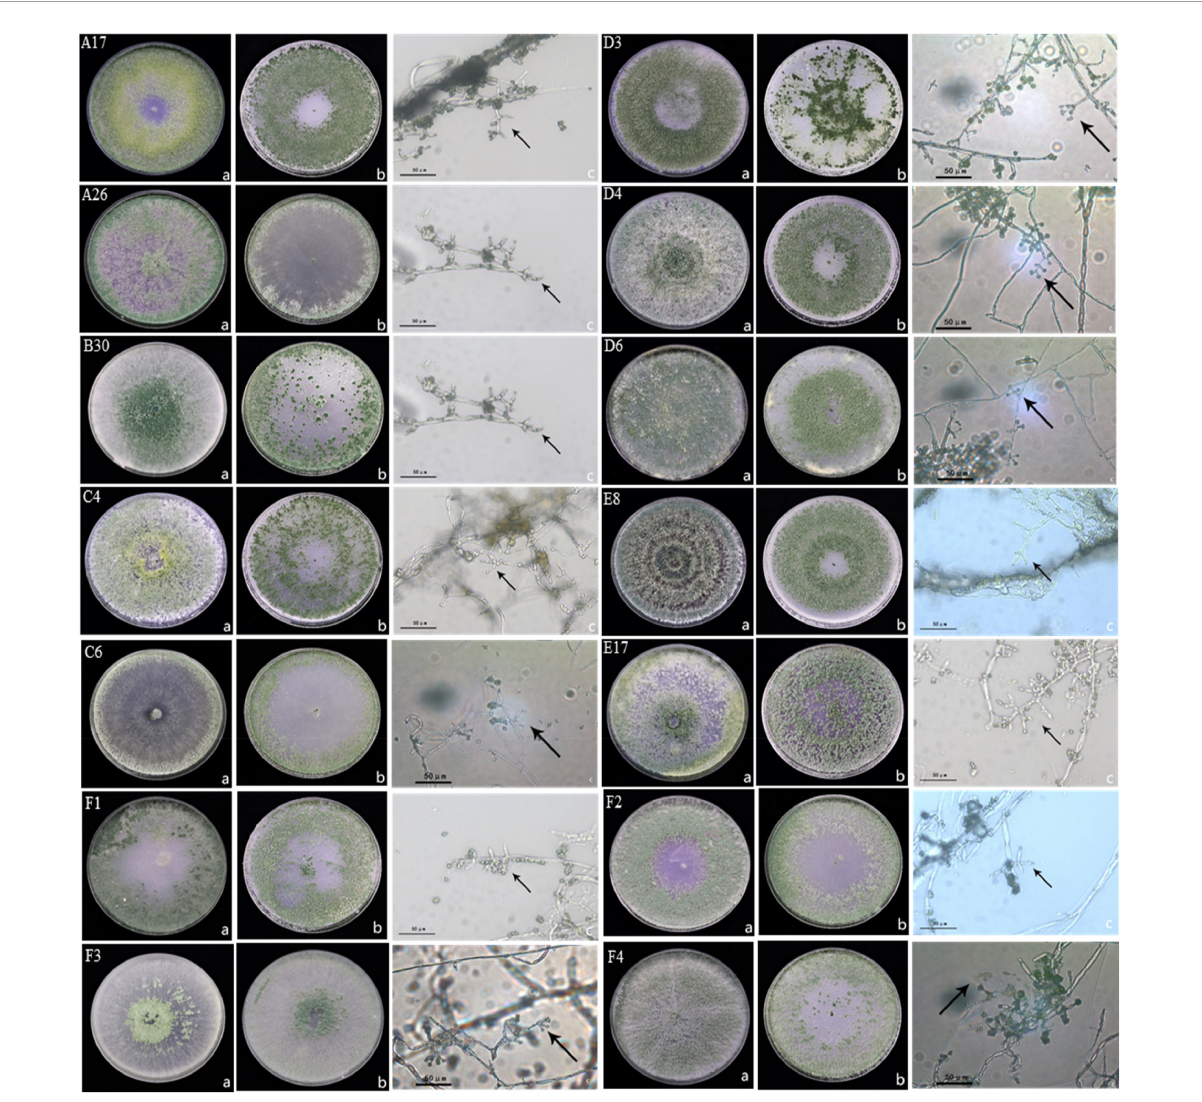
FIGURE1 Morphology of Trichoderma strains (A) morphology of Trichoderma strains in PDA medium at 7d, (B) morphology of Trichoderma strains in OA medium at 7d, and (C) characteristics of conidiophore under a 40 × microscope; A17, C4, D4, D6, and E8 were classified as Trichoderma harzianum ; B30, F1, and F2 were classified as Trichoderma koningiopsis ; A26, C6, and F4 were classified as Trichoderma hamatum ; E17 was classified as Trichoderma atroviride ; D3 was classified as Trichoderma brevicompactum , F3 was classified as Trichoderma tomentosum